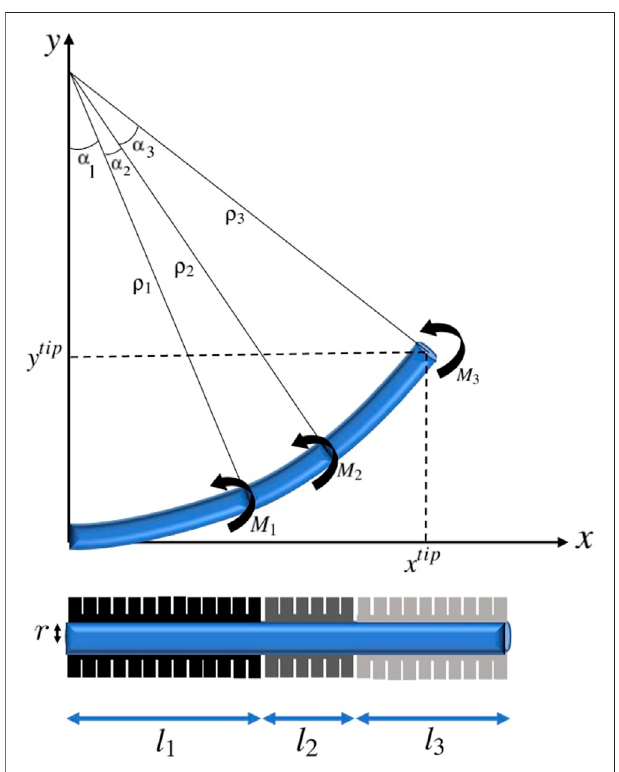
FIGURE 3 | A three-actuator soft catheter and its de fl ection under the moments corresponding to the pneumatic